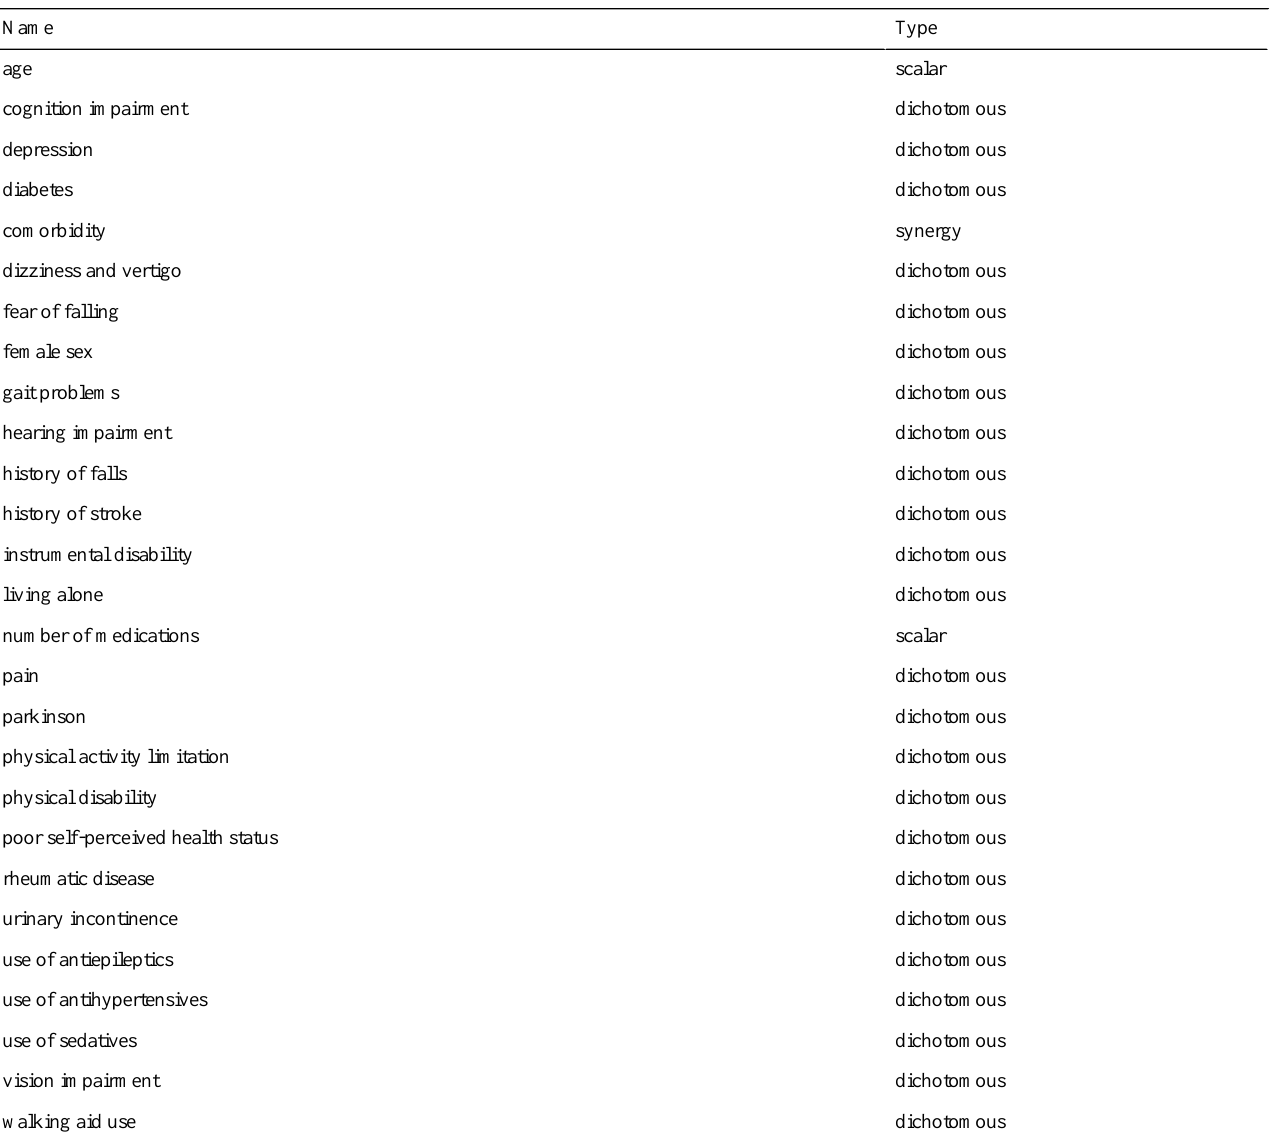
Table 1. Risk factor names and